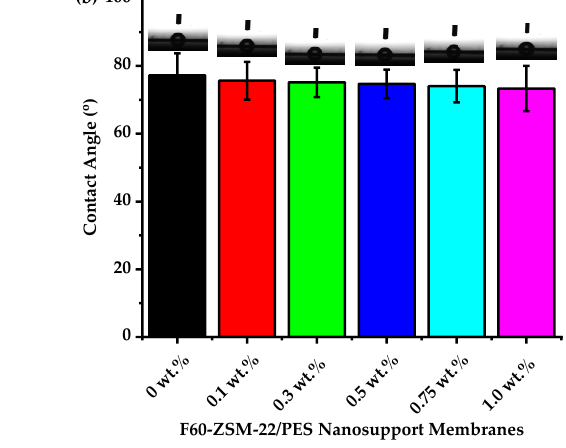
Figure 8. Contact angle measurements of nanofiltration membranes prepared via phase inversion to nominal wt.% loadings of 0, 0.1, 0.3, 0.5, 0.75, and 1.0 using ZSM-22: ( a ) C60-ZSM-22/PES and ( b ) F60-ZSM-22/PES as zeolite additives.